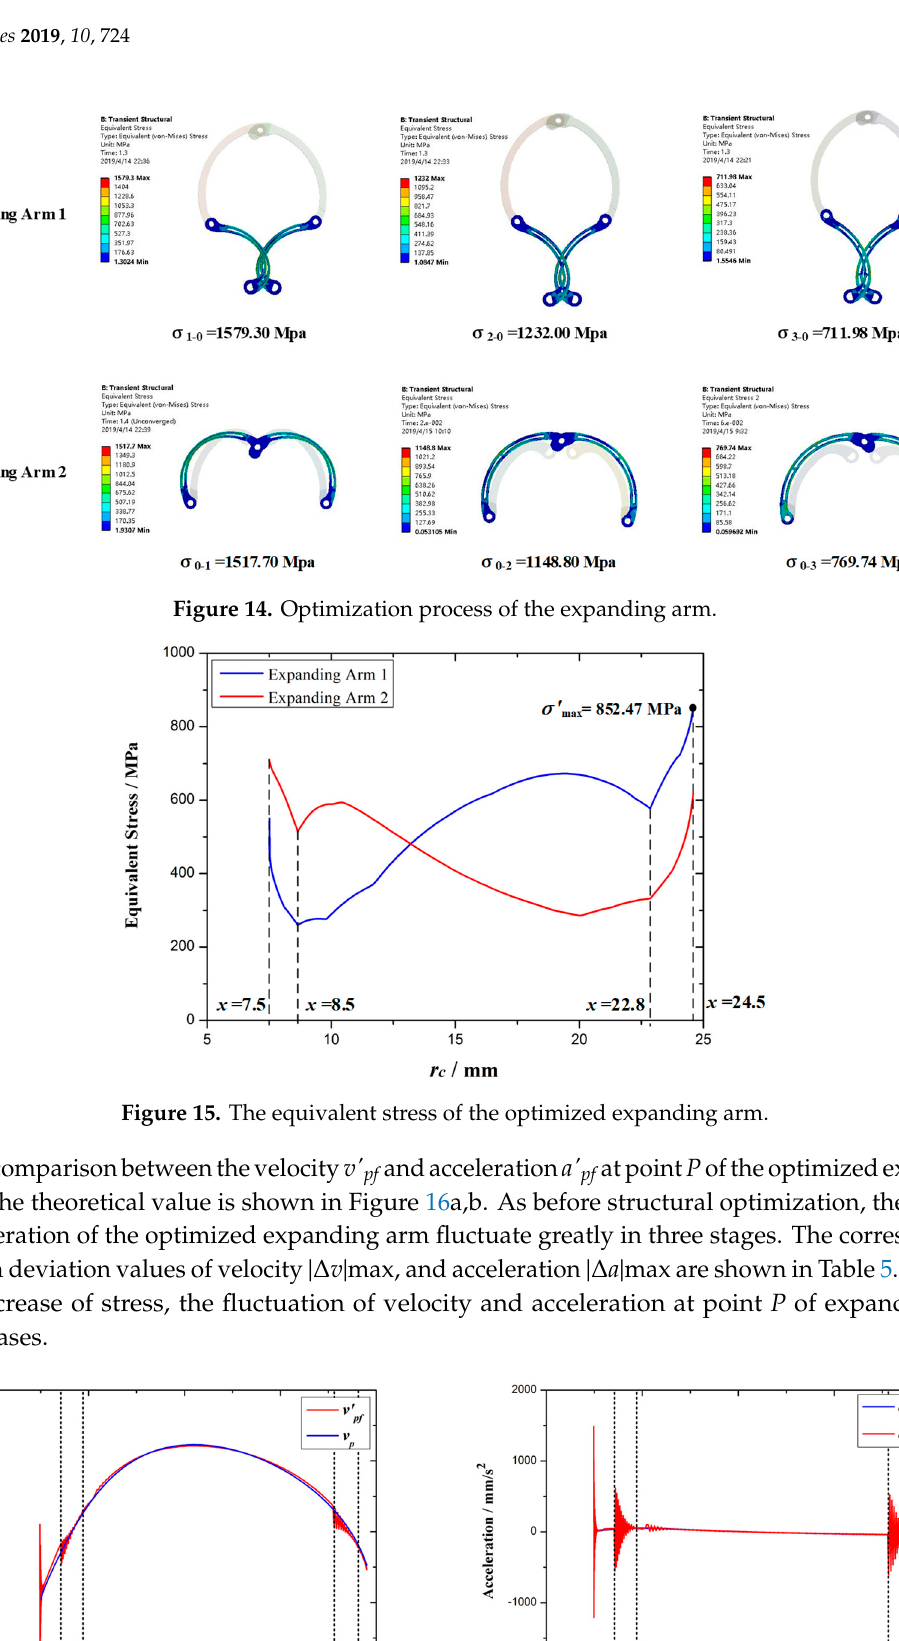
Figure 15. The equivalent stress of the optimized expanding arm.